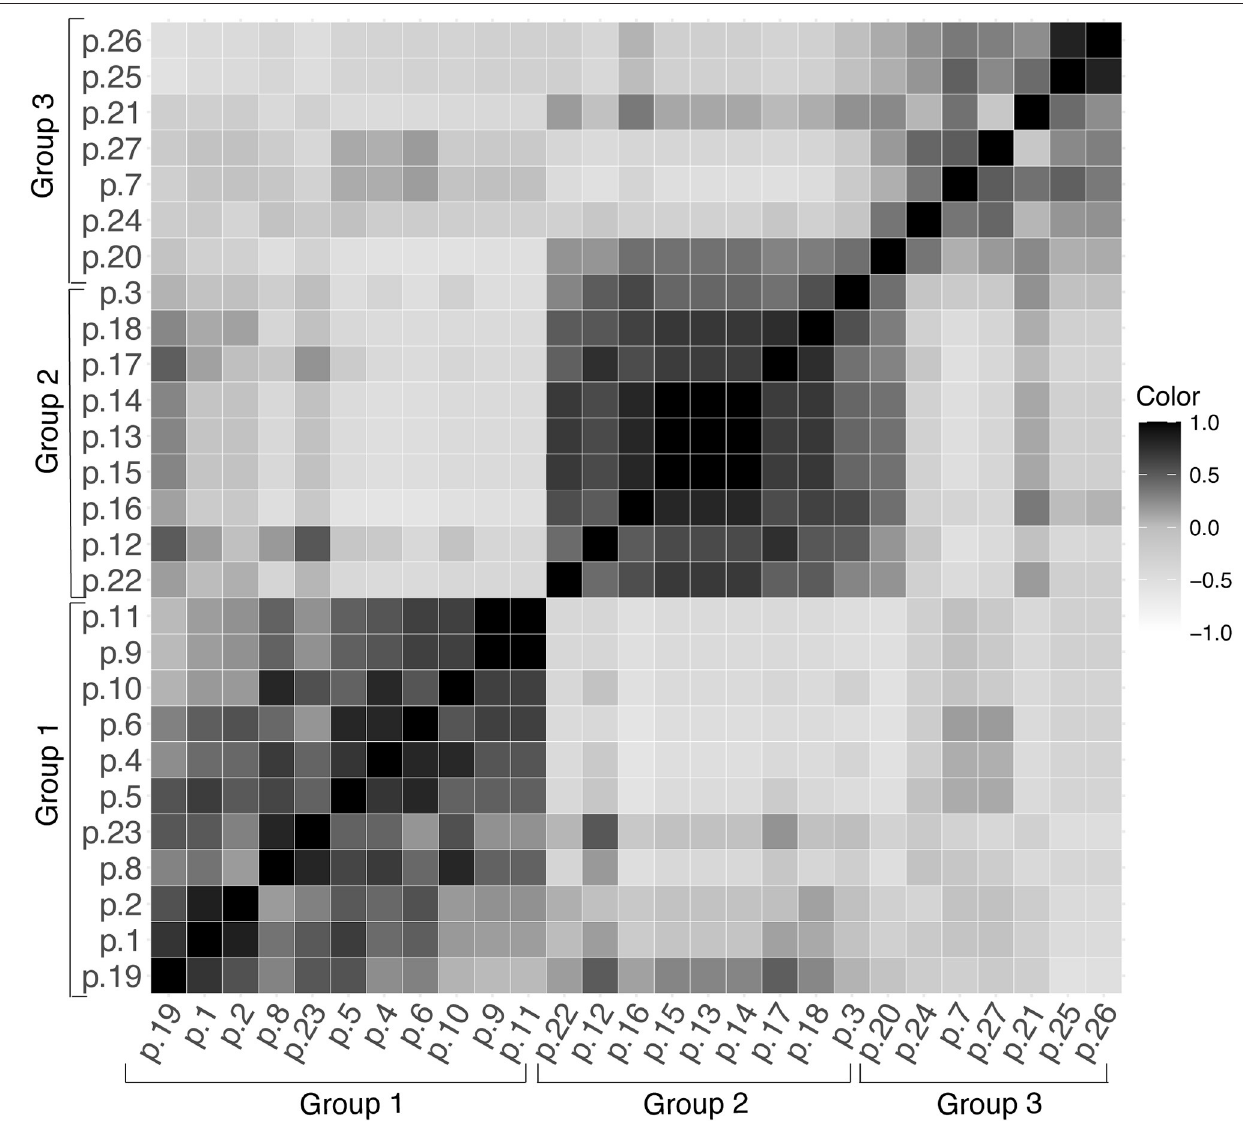
FIGURE 3 | DICE similarity coefficient represented in the range of 0 to ± 1 for the 27 samples of T. cruzi (DTU TcV), (p,